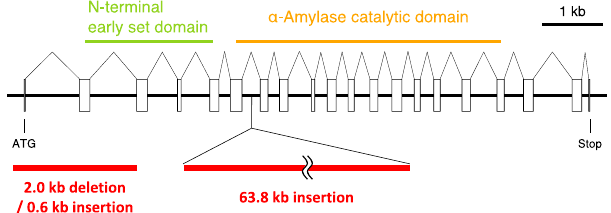
Fig. 2 Mutations in the ISA1 gene of Chlamydomonas sp. KOR1. Chlamydomonas sp. ISA1 encodes an isoamylase-type starch debranching enzyme (DBE), with an N-terminal early set domain and C-terminal α - amylase catalytic domain. Predicted exons are shown as white rectangles. Deletion and insertion mutation sites in KOR1 ISA1 are shown as red